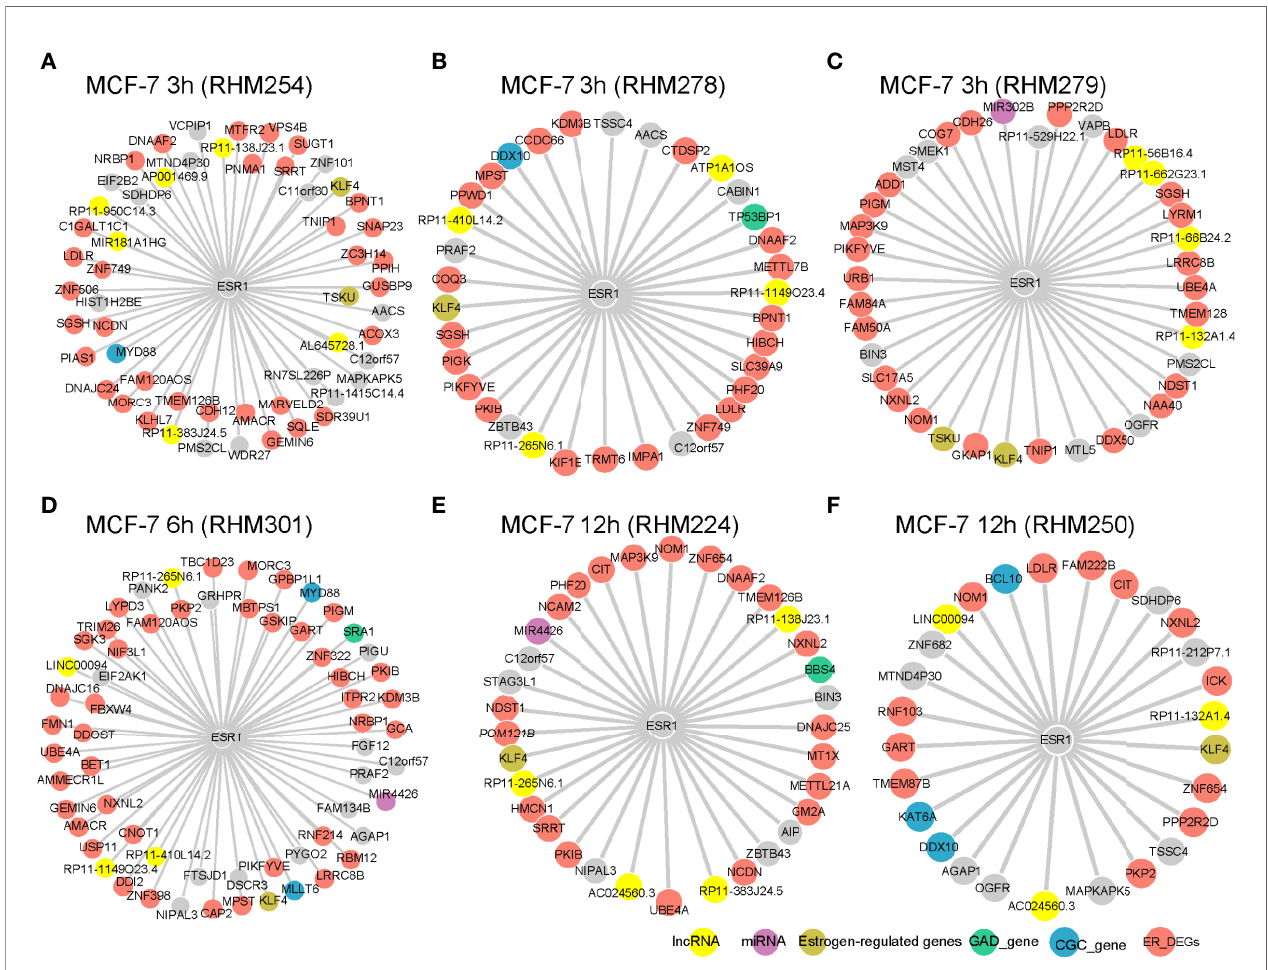
FIGURE 2 | ESR1 interactors in cell-speci fi c RCN. The yellow nodes represent lncRNAs, purple nodes represent miRNAs, green nodes represent GAD genes, blue nodes represent CGC genes, khaki nodes represent estrogen regulated genes, salmon nodes represent DEGs between ER+ vs ER − patients from either TCGA or METABRIC, and gray nodes represent genes with an unknown “ biological ” label. The RCN is shown for the (A) MCF-7 3 h (RHM254), (B) MCF-7 3 h (RHM278), (C) MCF-7 3 h (RHM279), (D) MCF-7 6 h (RHM301), (E) MCF-7 12 h (RHM224), and (F) MCF-7 12 h (RHM250)